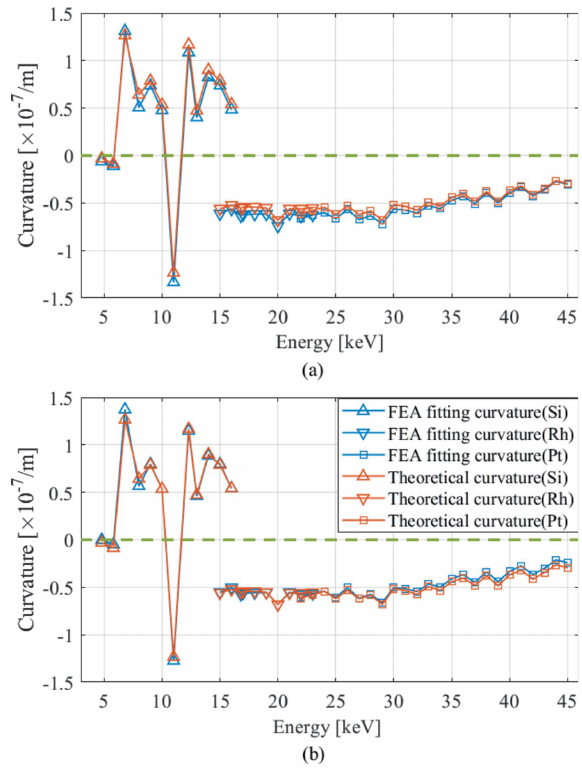
Figure 5 Comparison between theoretical curvatures and FEA fitting curvatures. The green dashed line shows where the curvature equals zero. ( a ) FEA fitting curvatures without calculating c 0 and ( b ) taking c 0 into